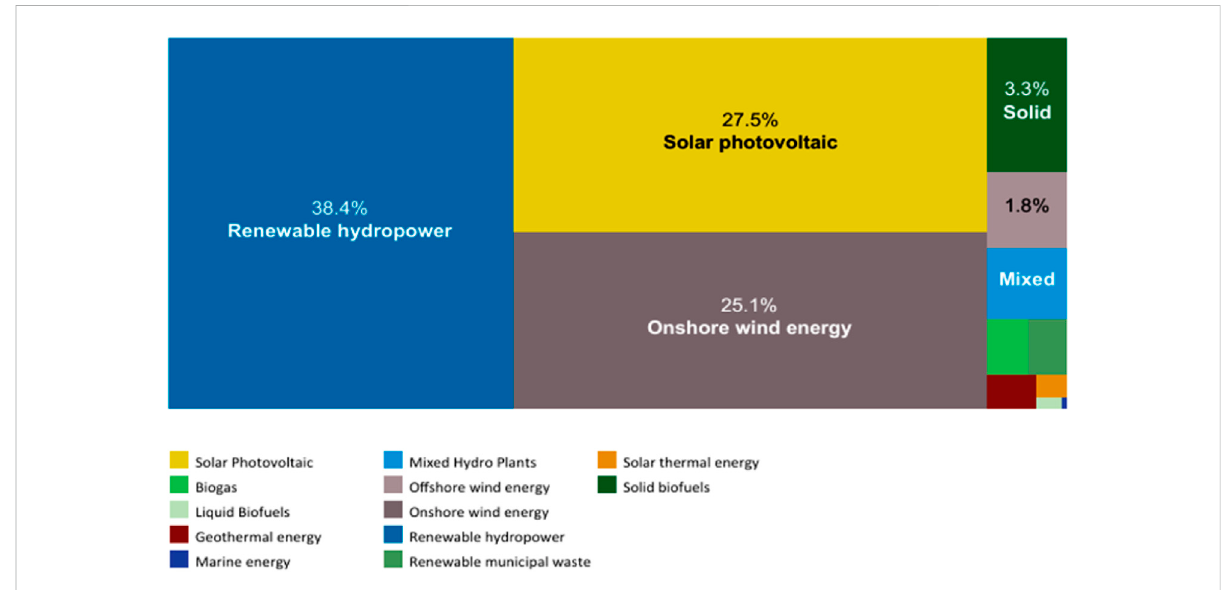
FIGURE 1 Contribution by renewable energy sources in total power